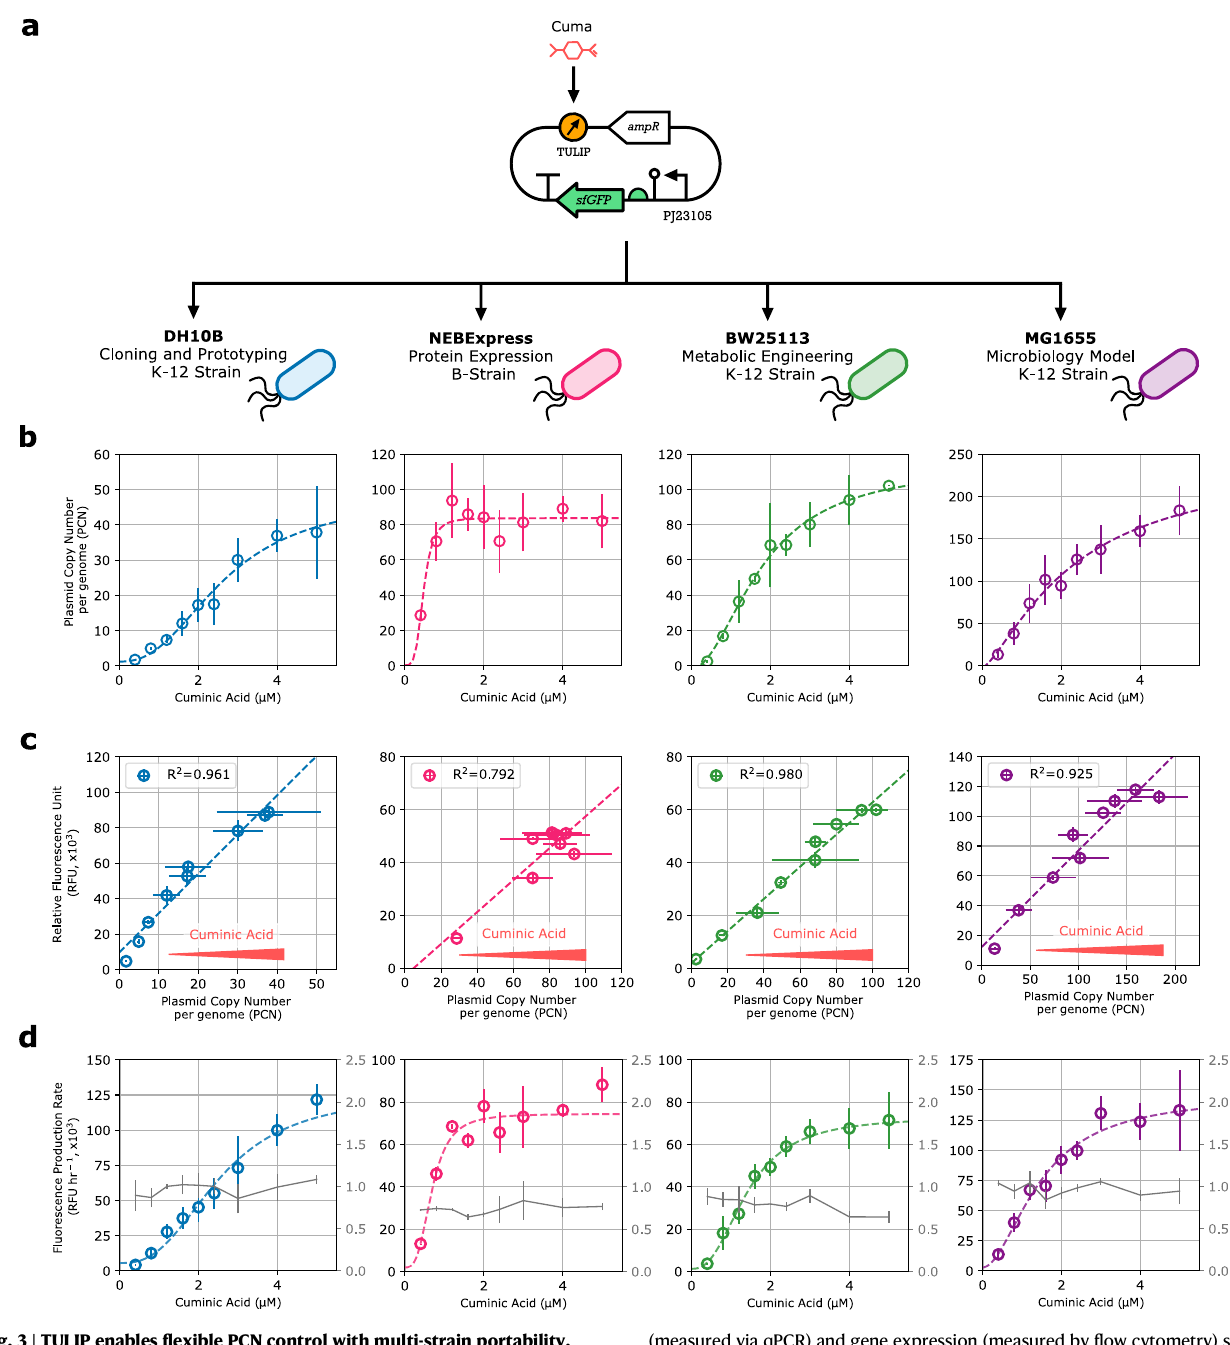
(measured via qPCR) and gene expression (measured by fl ow cytometry) show strong linear correlation, as seen for the fPCN collection (Fig. 1) and for TULIP in NEBStable (Fig. 2). d Fluorescence production rate and growth rate (gray) were monitored in microplate reader